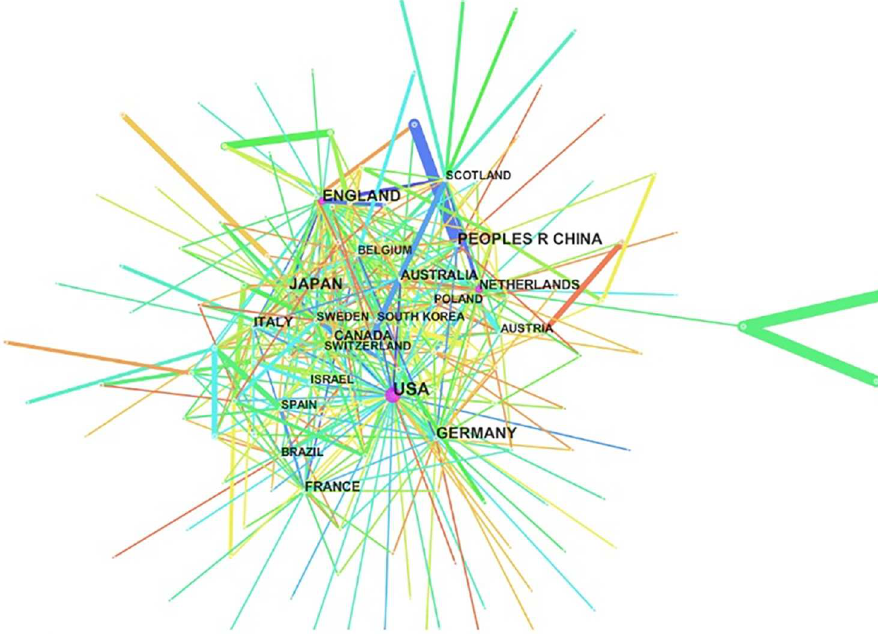
Fig 2. Map of countriesand territoriesof groups thatpublishedarticlesrelatedto regulatoryT cell (Treg) research from 2000 to 2015.